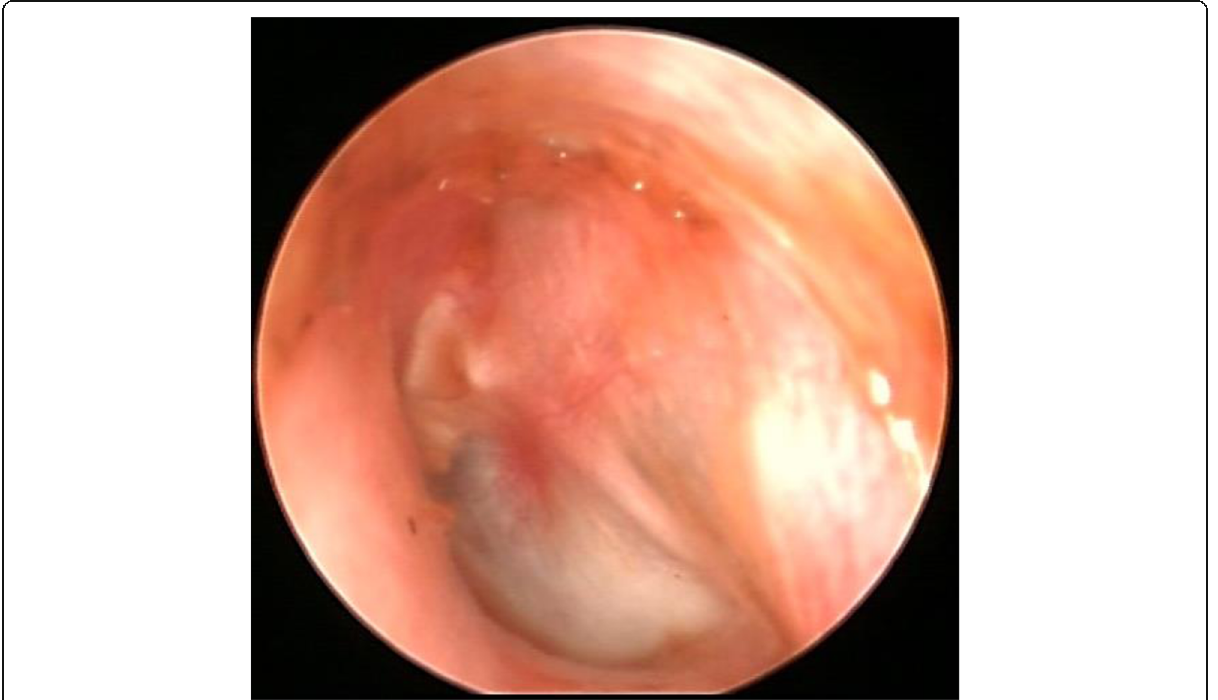
Fig. 1 Bulging left tympanic membrane at the postero-superior quadrant, with presence of a whitish mass medial to it